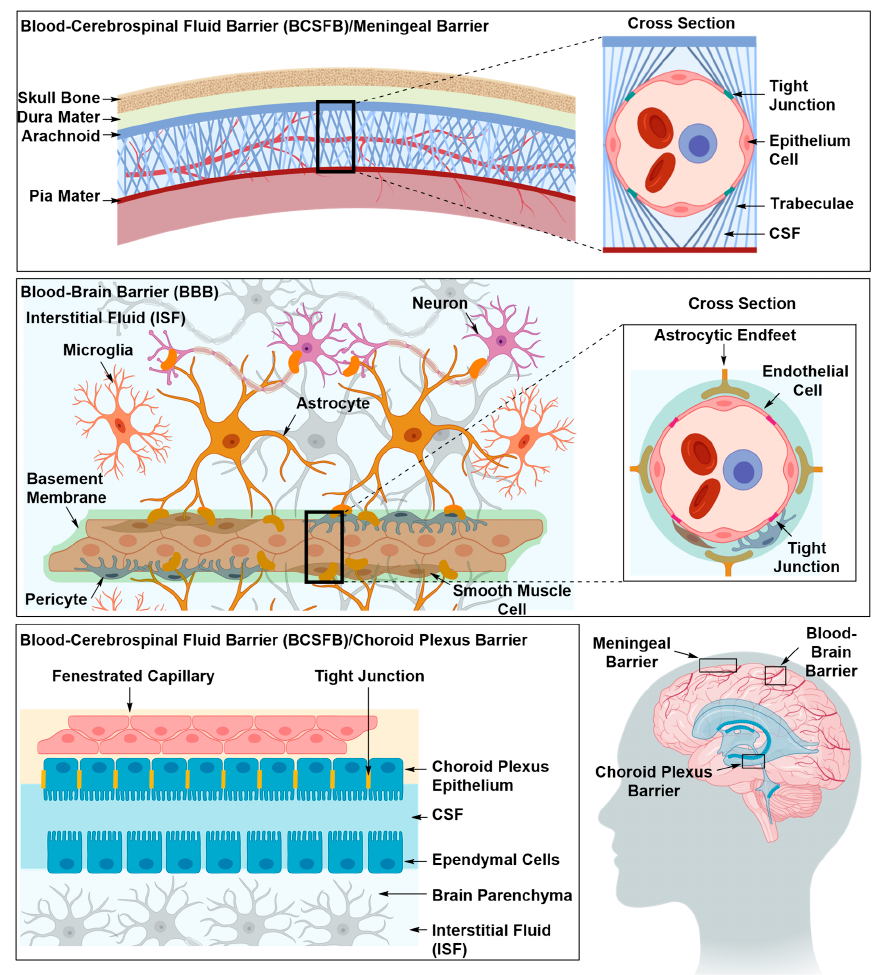
Figure 1. The three main barriers in the central nervous system (CNS), namely the meningeal or arachnoid barrier, the choroid plexus barrier and the blood brain barrier (BBB). The arachnoid and choroid plexus barriers separate the blood from the cerebrospinal fluid (CSF), and the BBB separates the blood from the interstitial fluid (ISF). At each site, the barrier is mainly formed by tight junctions that seal o ff the paracellular space. The blood brain barrier possesses an intricate architecture of basement membrane, mural and glial cells that work in synergy to maintain the barrier’s integrity and regulate its permeability in response to neuronal